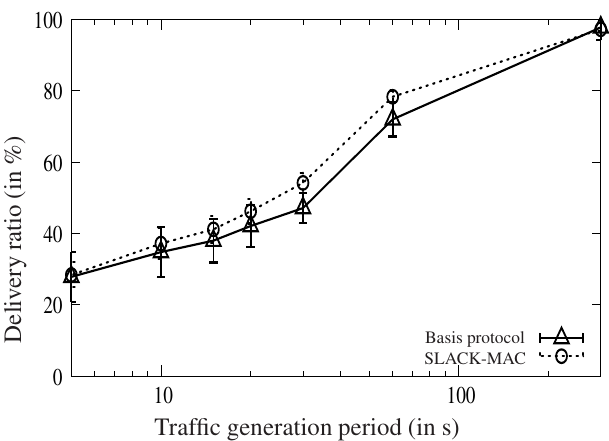
Figure 11. Delivery ratio as a function of the traffic generation period, for a duty-cycle of 1%, and for the Basic protocol and SLACK-MAC.